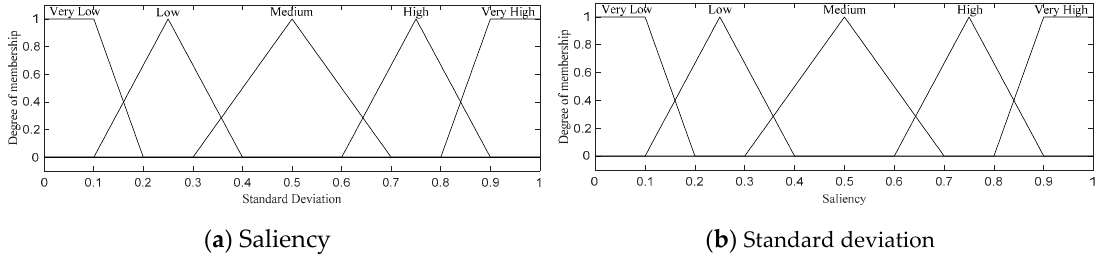
Figure 4. Two fuzzy input variables for feature selection.